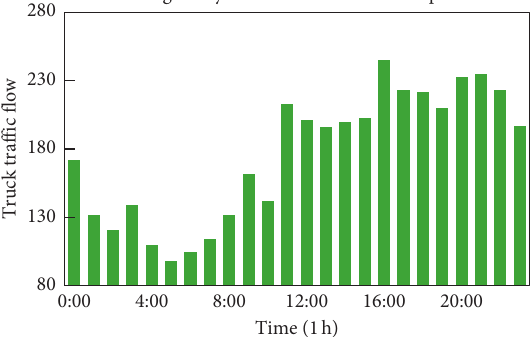
Figure 5: The average daily truck traffic flow.